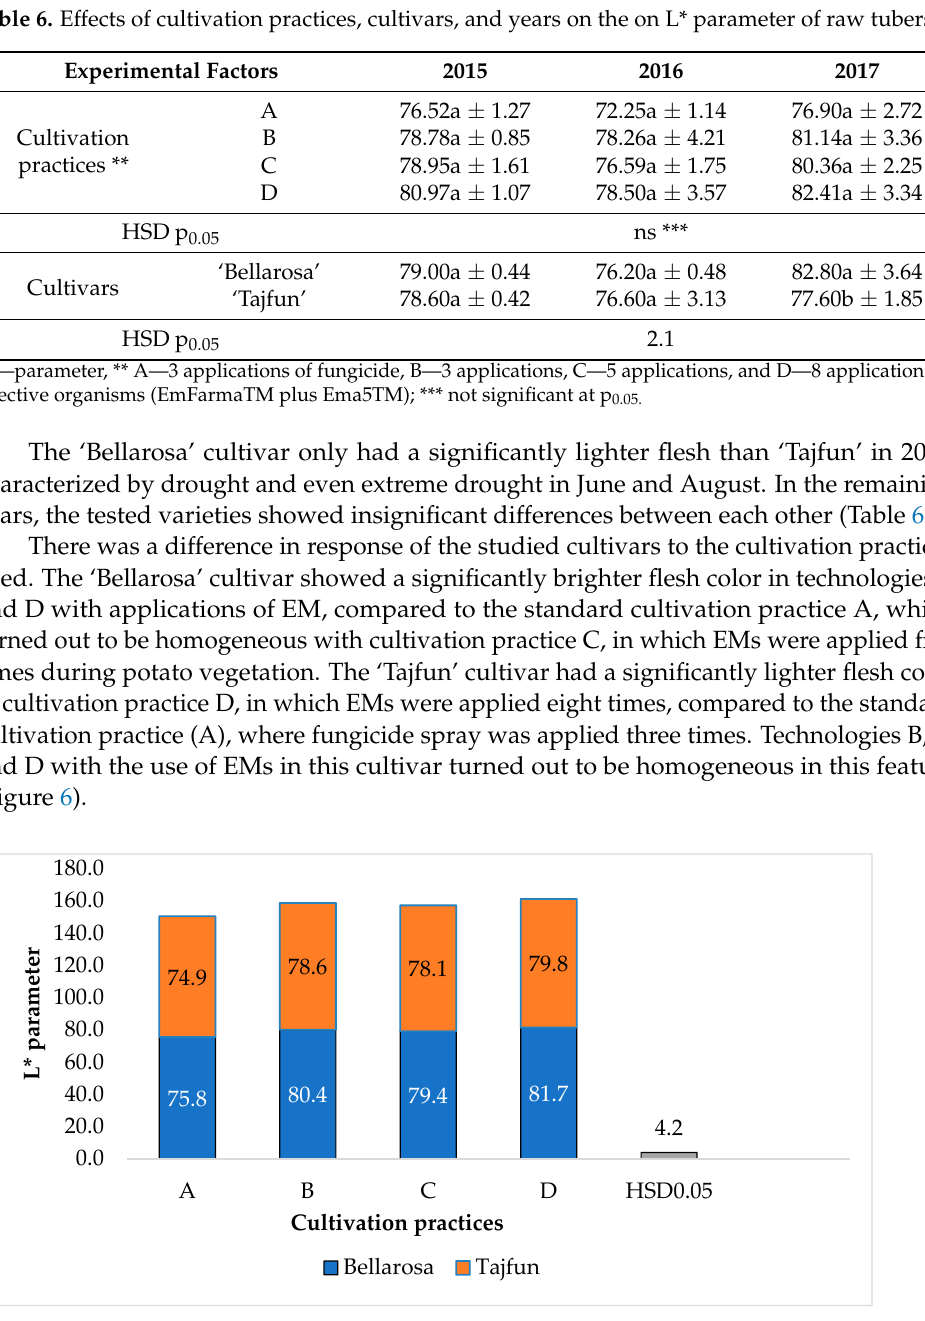
Figure 6. Influence of cultivation practices and cultivars on brightness of potato tuber flesh (L*) (scale 0 ‒ 100, 0 (black) to 100 (white)) [5,26]. Cultivation practices: A—3 application of fungicide, B—3 applications, C—5 application and D—8 applications of effective organisms (EmFarma TM plus Ema5 TM ).